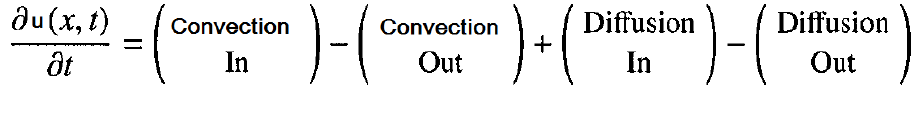
Fig. 2. A conceptual rate equation with respect to the convection-diffusion